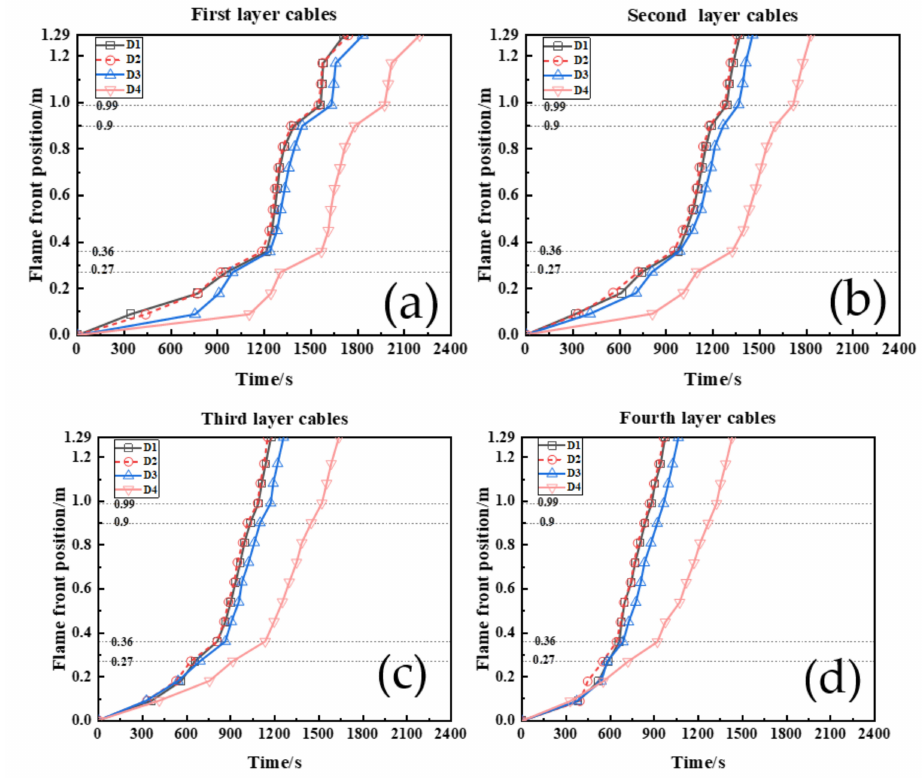
Figure 12. Cable extension at different ignition positions: ( a ) First layer of cables; ( b ) Second layer of cables; ( c ) Third layer of cables; ( d ) Fourth layer of cables.